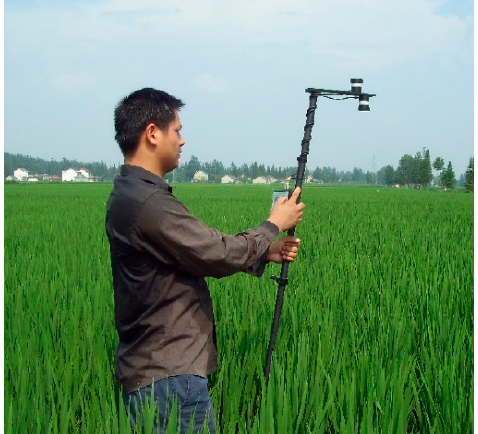
Figure 13. Collection of spectral data by using CGMD.